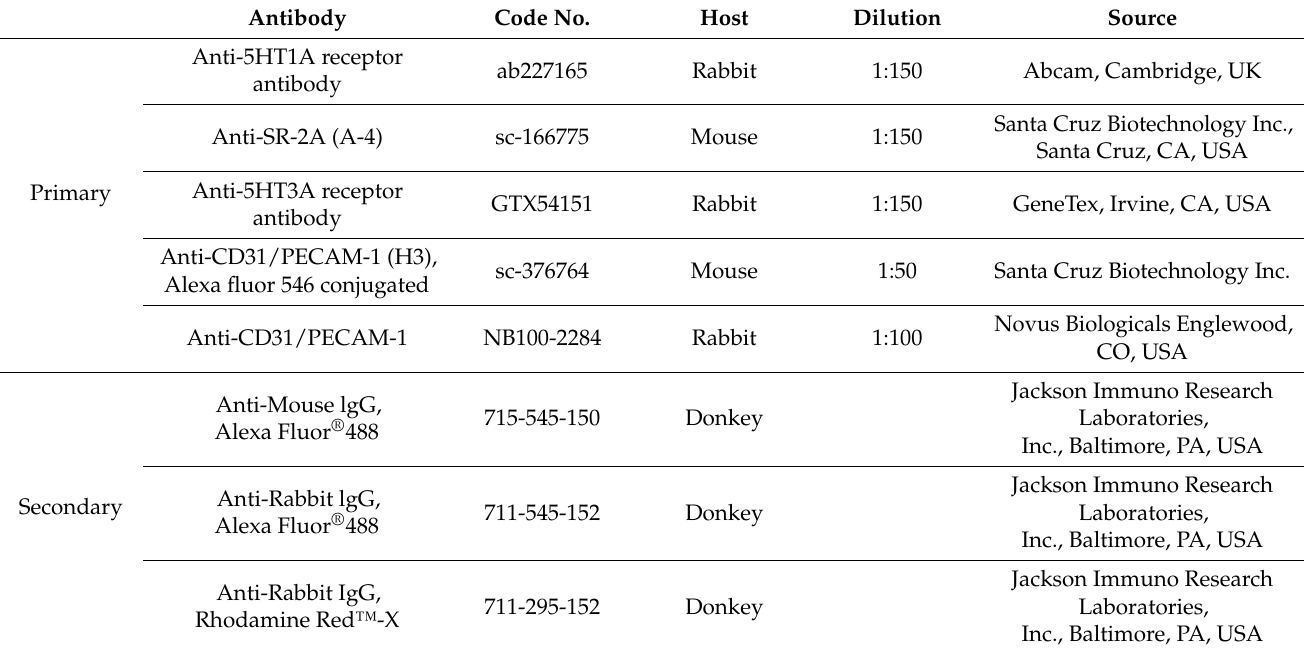
Table 2. Primary and secondary antibodies used in the